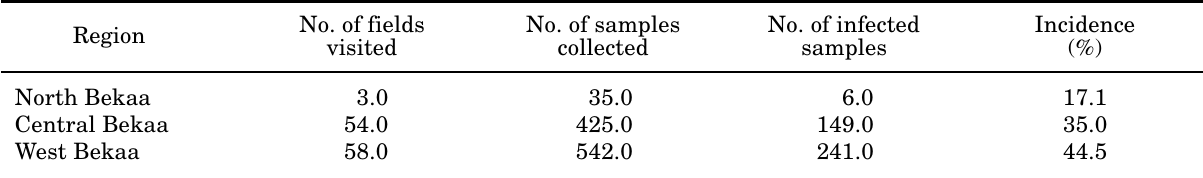
Table 1. Percent incidence of viral infections on sugar beet in three regions of the Bekaa valley in Lebanon. Region